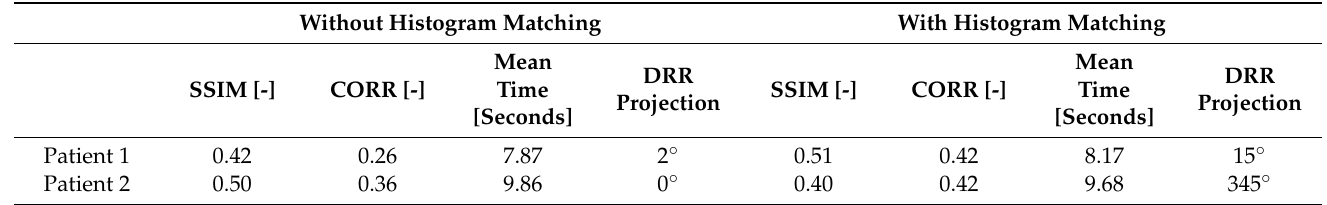
Table 5. Summary of similarity metrics and mean computation times of two datasets in an angle range of 30 ◦ .